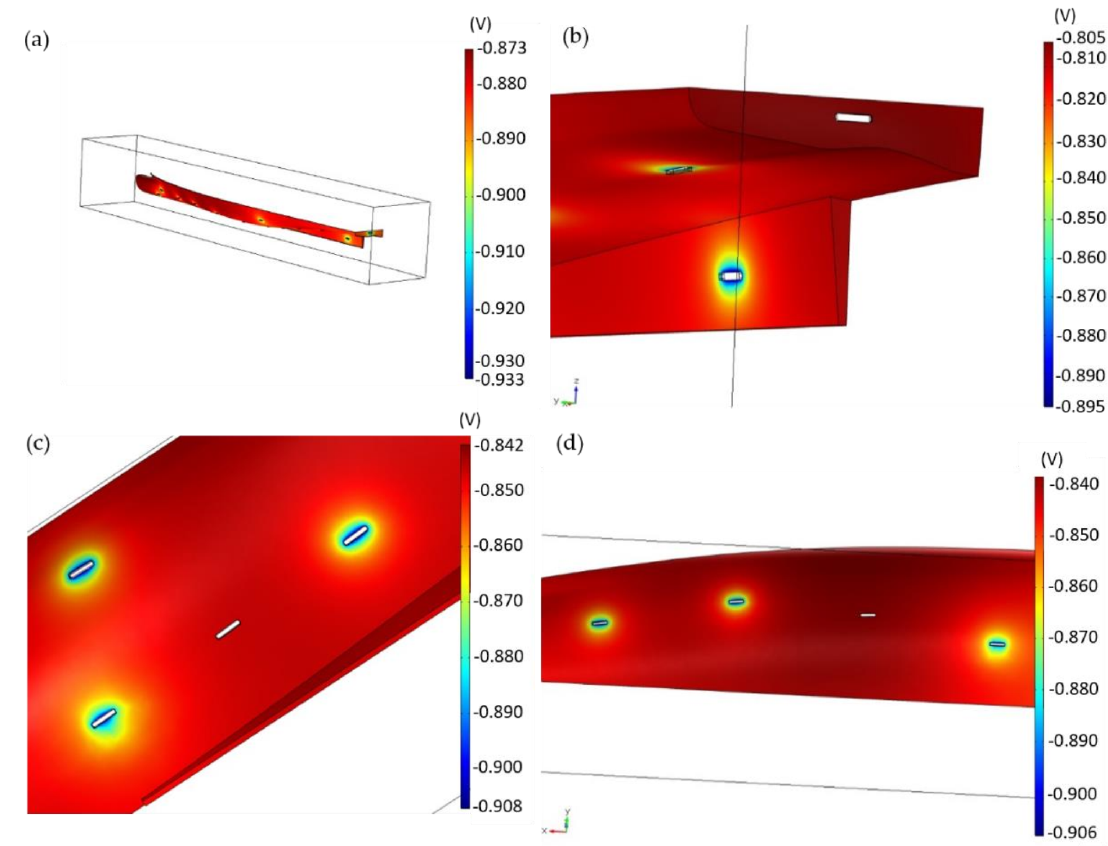
Figure 8. ( a ) Global view of the results of the numerical analysis with 7 kg anodes. ( b – d ) show the effect of deactivation of one anode in ( b ) transom, ( c ) stern body, ( d ) central